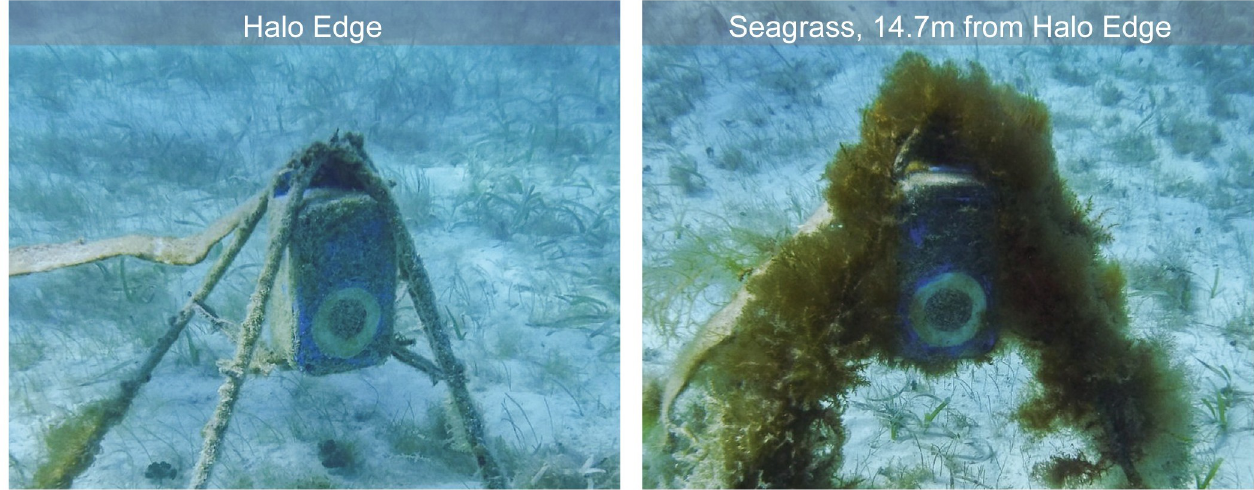
Fig 4. Comparison of biofouling and algal overgrowth after a month based on location. Structures were located at the edge of the halo, adjacent to seagrass (left), and in the middle of the surrounding seagrass (right). Similar results seen across all camera sites suggest that reef-based herbivores help to control algal growth both within and at the edges of the halo but do not graze heavily, if at all, on algae and related marine organisms in the surrounding algal or seagrass beds. Reprinted from [39] under a CC BY license with permission.